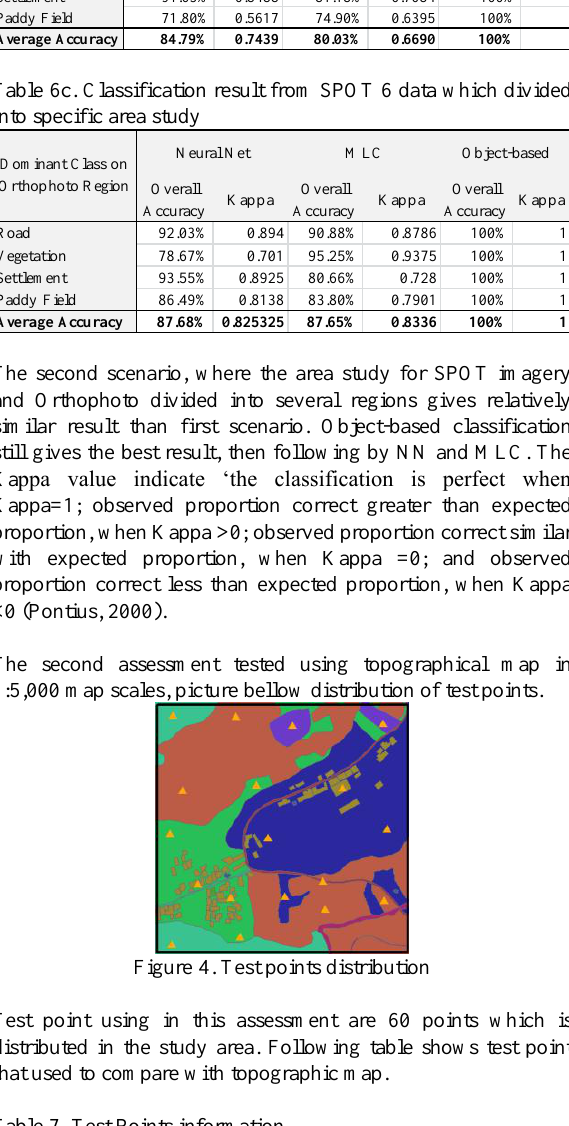
Table 7. Test Points